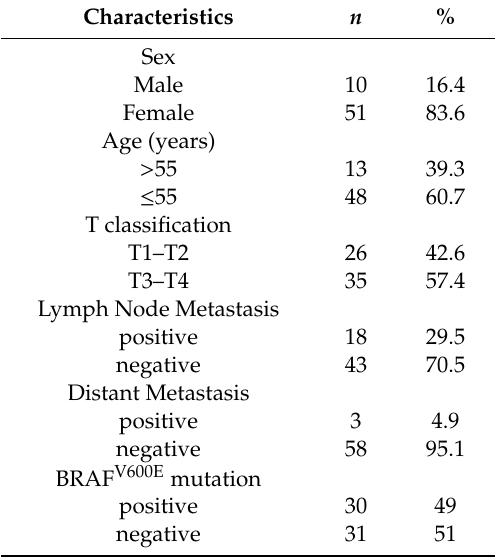
Table 1. Characteristics of papillary thyroid cancer patients from whom PTC tissue has been